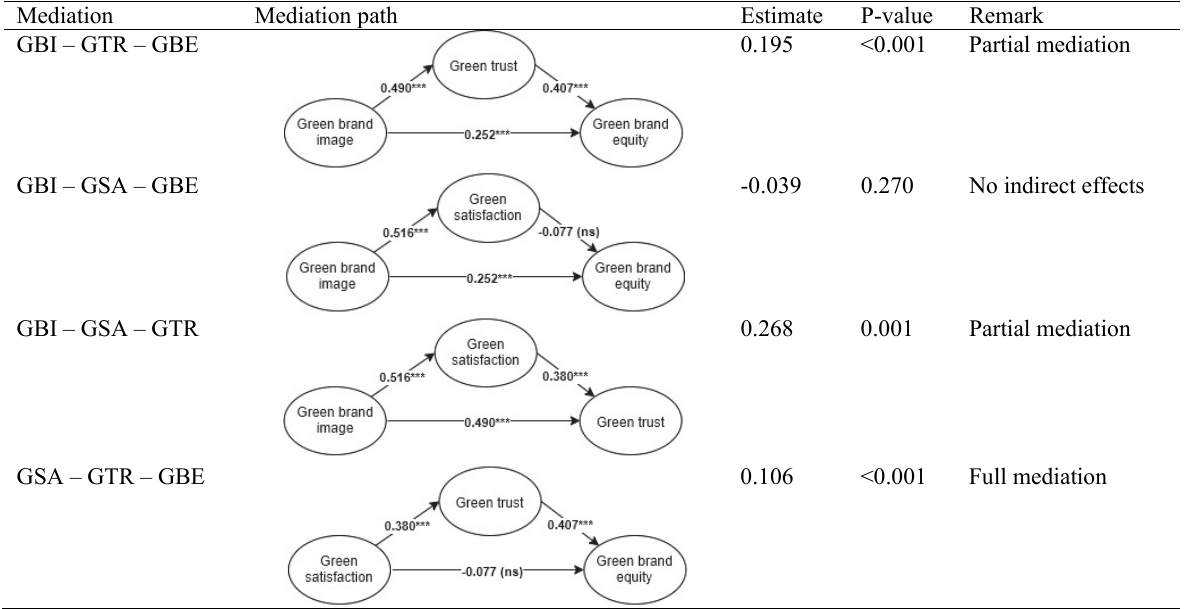
Mediation analysis results